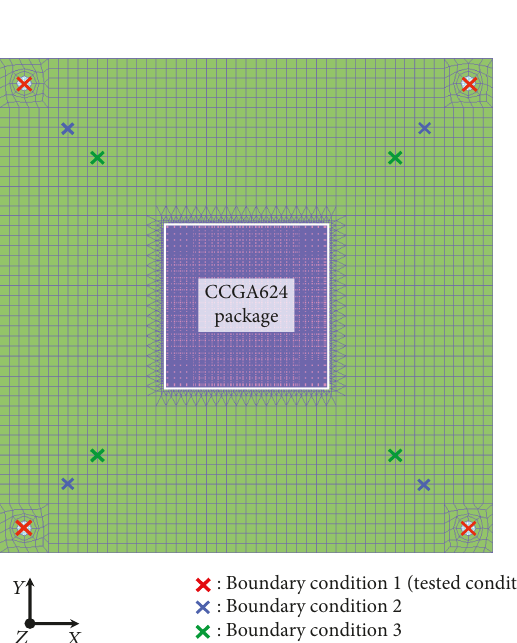
Figure 12: Various boundary conditions for structural analysis.